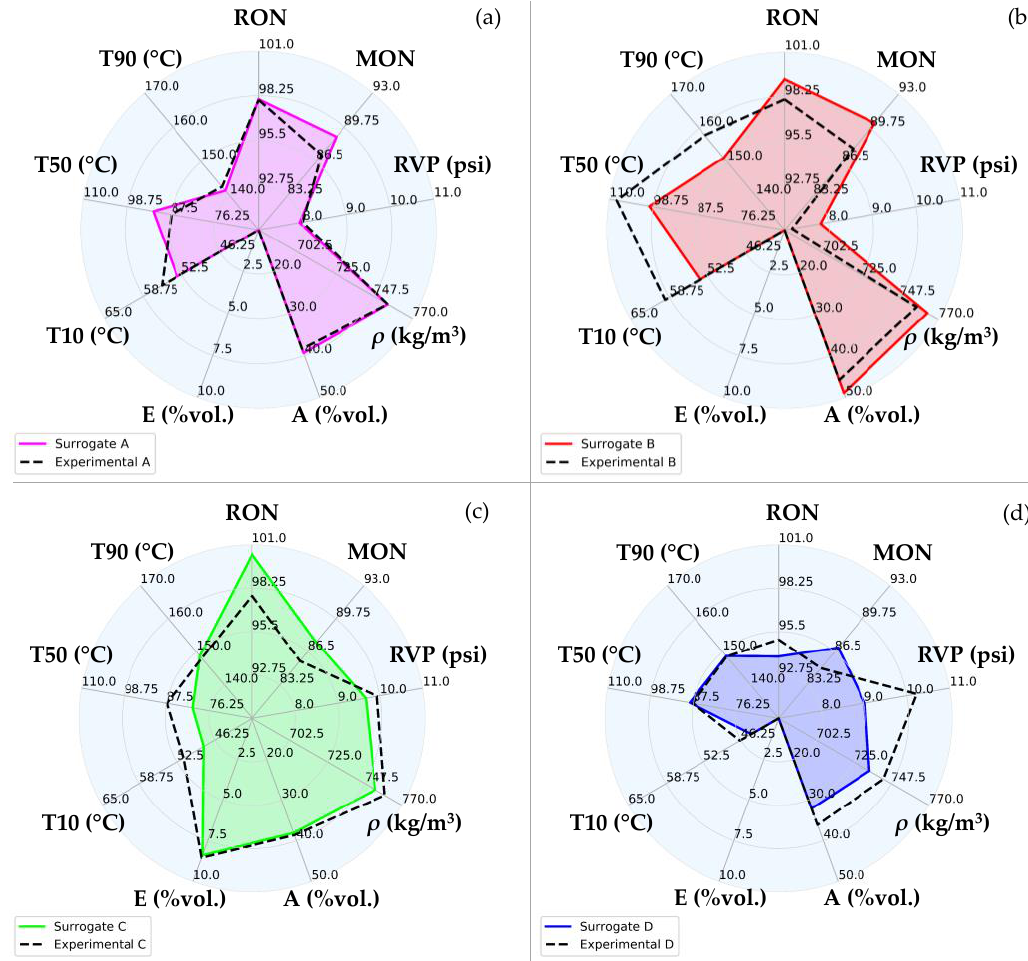
Figure 7. Comparison between different properties (RON, MON, RVP, liquid density ( ρ ), aromatics volume, ethanol volume, T10, T50, T90) of the optima surrogates (filled polygon) and of the associated experimental gasoline (dashed-line empty polygon). The comparison is shown for the four validation gasolines A ( a ), B ( b ), C ( c ), D ( d